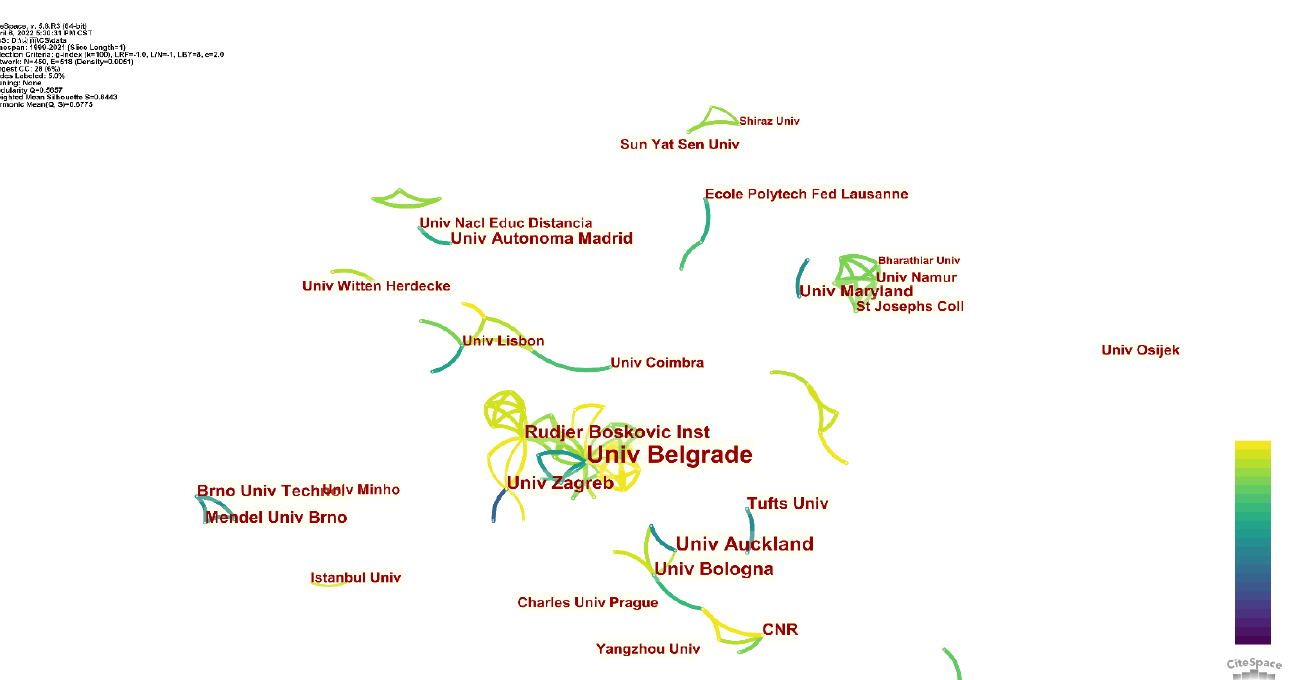
Figure 7. Institution network of published papers for the evaluation of antioxidants using electro- chemical sensors.